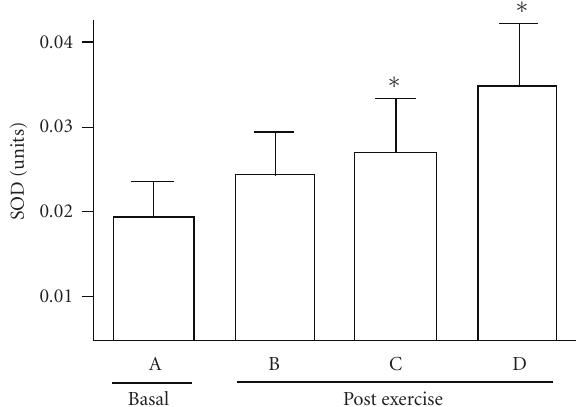
Figure 3: Glutathione reductase (GR) activity in plasma from 34 male healthy subjects during basal (A) and immediately after three exercise tests (B, C, and D). Data is expressed as mean ± standard error. ∗ denotes statistical di ff erences ( P < . 05) versus basal status.